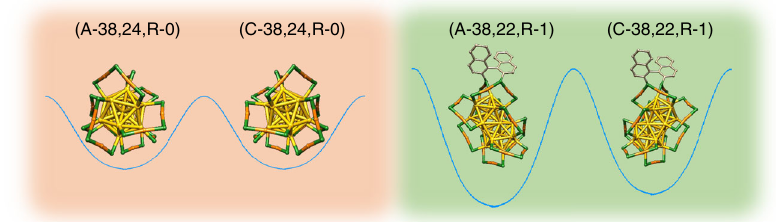
Fig. 1 Potential energy curves of Au 38 (2-PET) 24 enantiomers and R-BINAS-substituted diastereomers. Color code: yellow, Au core ; orange, Au adatom ; green, S. The 2-PET ligand is omitted for clarity. Nomenclature: (A-38, 22, R-1) means anticlockwise cluster with one R-BINAS and 22 2-PET ligands in its ligand